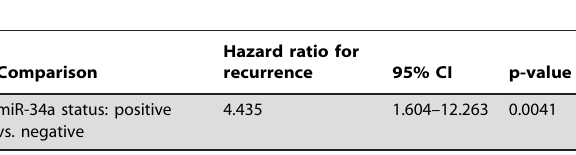
Table 8. Multivariate analysis of patients not treated with adjuvant therapy: disease-free